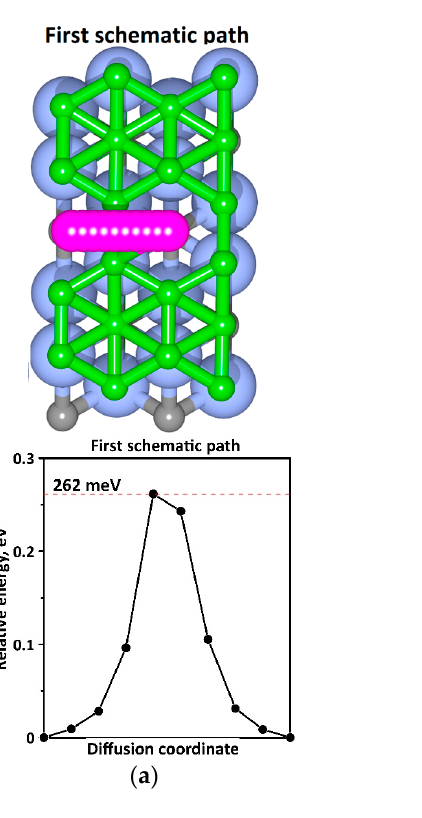
Figure 6. The Mg diffusion paths along the borophene monolayer: ( a ) Mg migration path along empty hexagons; ( b ) Mg migration path along hexagons with a boron atom in the center; ( c ) Mg migration path from the hexagon with the boron atom in the center to the empty hexagon.